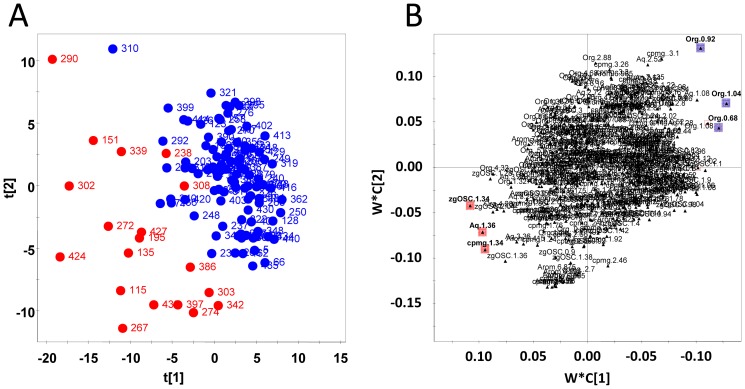
PLS-DA analysis of 1H NMR spectral data.
(A) PLS-DA t1/t2 score plot derived from 1H NMR spectral data correlating to 86% of the Y-variance. The plot shows how well individuals separate whether it is a survivor (blue spot) or a deceased (red spot) individual (number is for the identification of individual). (B) PLS-DA weight plot (w*c1/w*c2). This plot of the X- and Y-weights (w* and c) shows how the 1H NMR spectral data correlate with class belonging i.e. the survival or 30-day mortality classes. Variables corresponding to the 6 first higher variable influence parameters have a colored box; red when there are positively correlated with 30-day mortality class and blue when there are positively correlated with survival class. The triangles were labeled by spectral data identification. List of these discriminating variables is in Table 2.